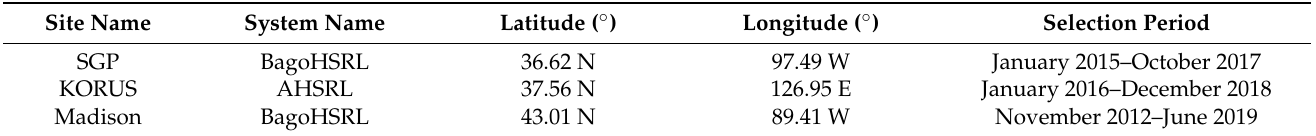
Table 1. The information of UW-HSRL sites, which includes the site name, system name, longitude, latitude, and data selection